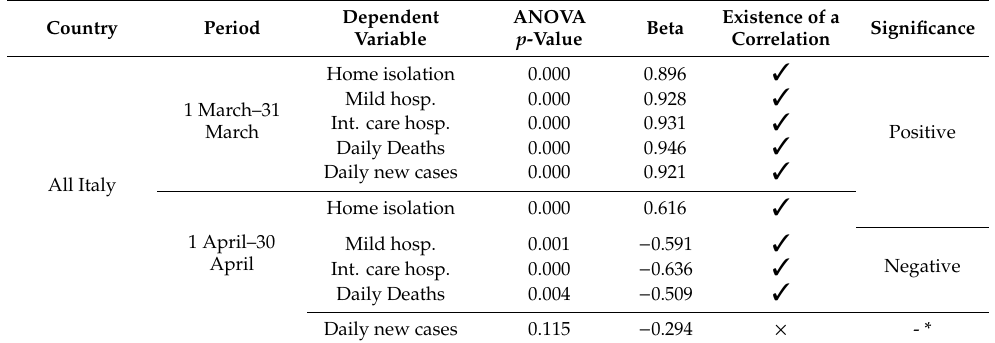
Table 3. Test No. (Independent variable) vs. each outcome variable within two time periods (All Italy). Country Period